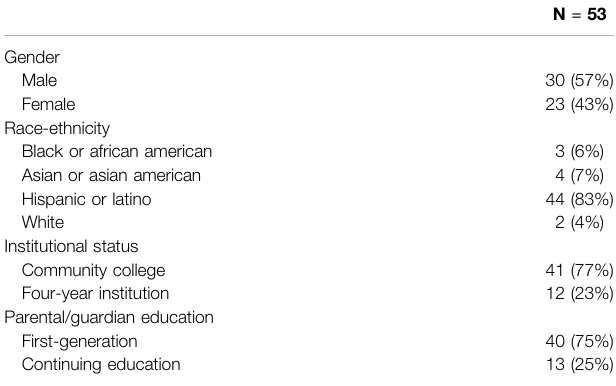
TABLE 1 | Demographic